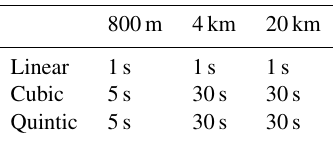
Table A2. Time step used with the fourth-order Runge–Kutta method to obtain the reference solutions used in Sect. 5 for each order of interpolation and each